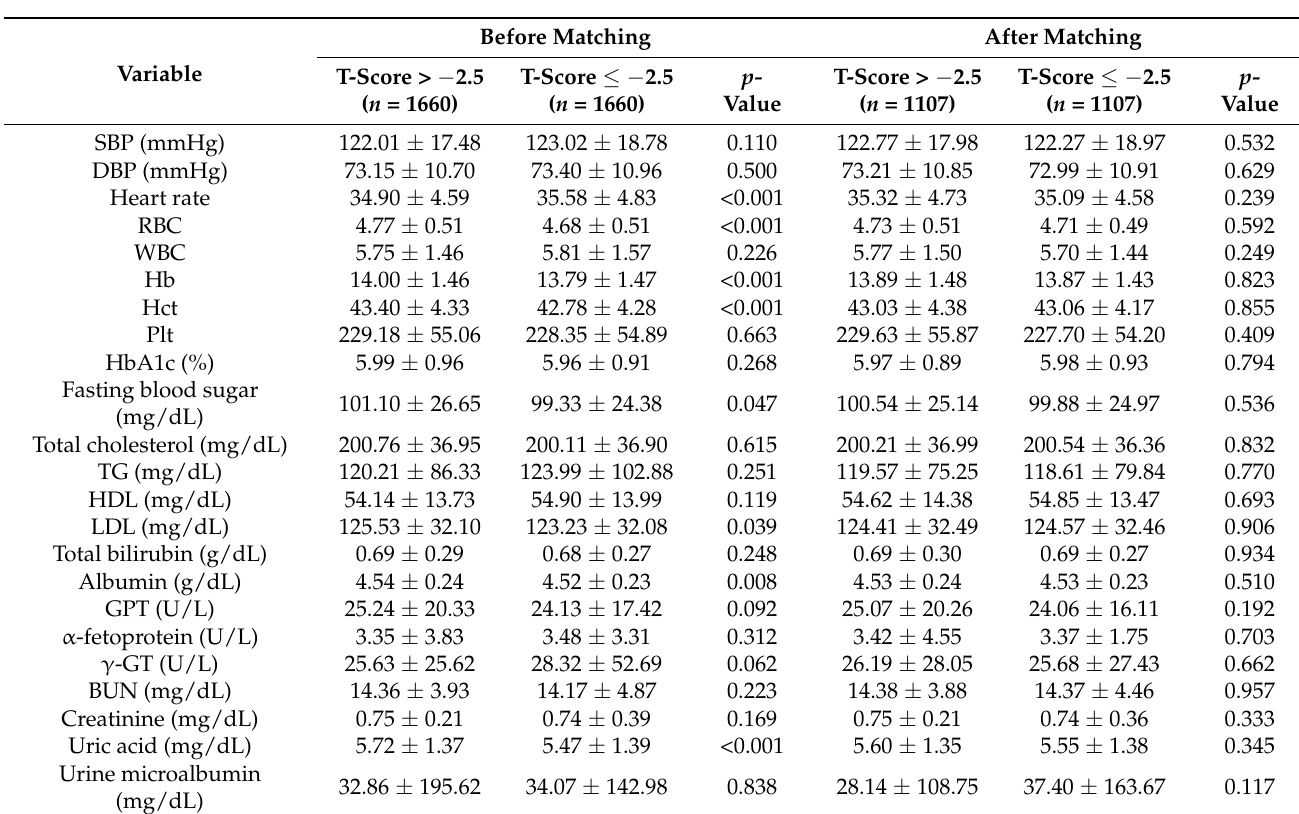
Figure 1. Comorbidities in osteoporosis and non-osteoporosis group. Table 2. Physiological parameters and biochemistry